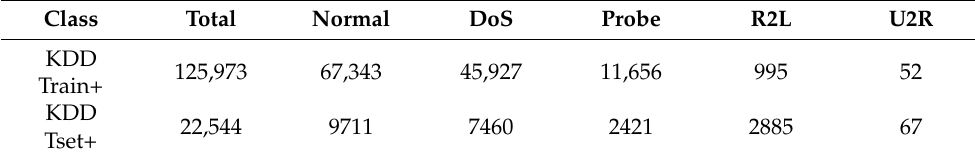
Table 1. Class composition of